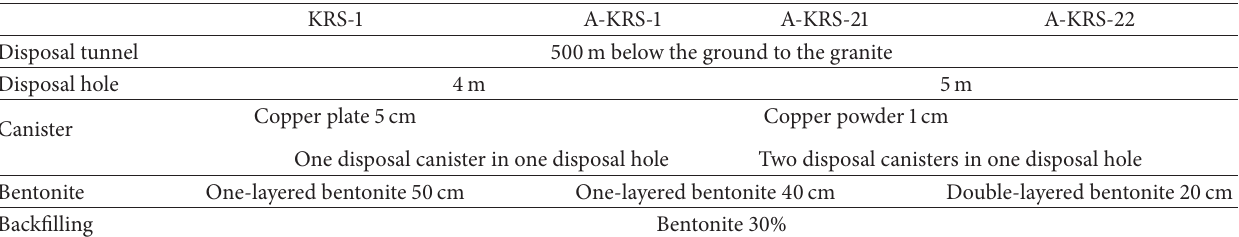
Table 1: The features of disposal alternatives.